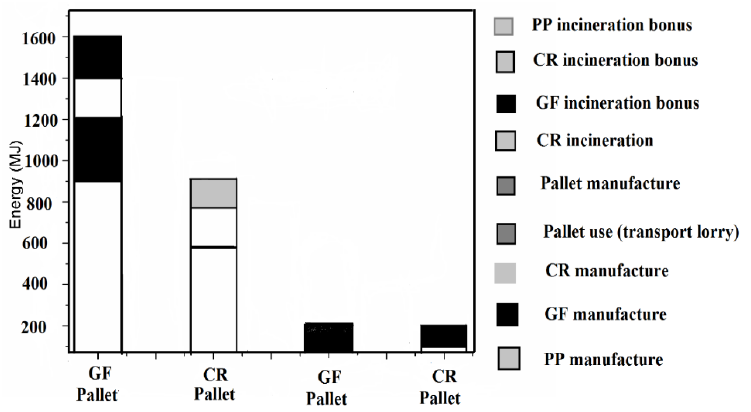
Figure 3. Life cycle assessment (LCA) study for energy consumption for the glass fibre (GF) and China reed (CR) pallets. Reprinted with permission from Reference [21]. Copyright 2001, with permission from Elsevier.